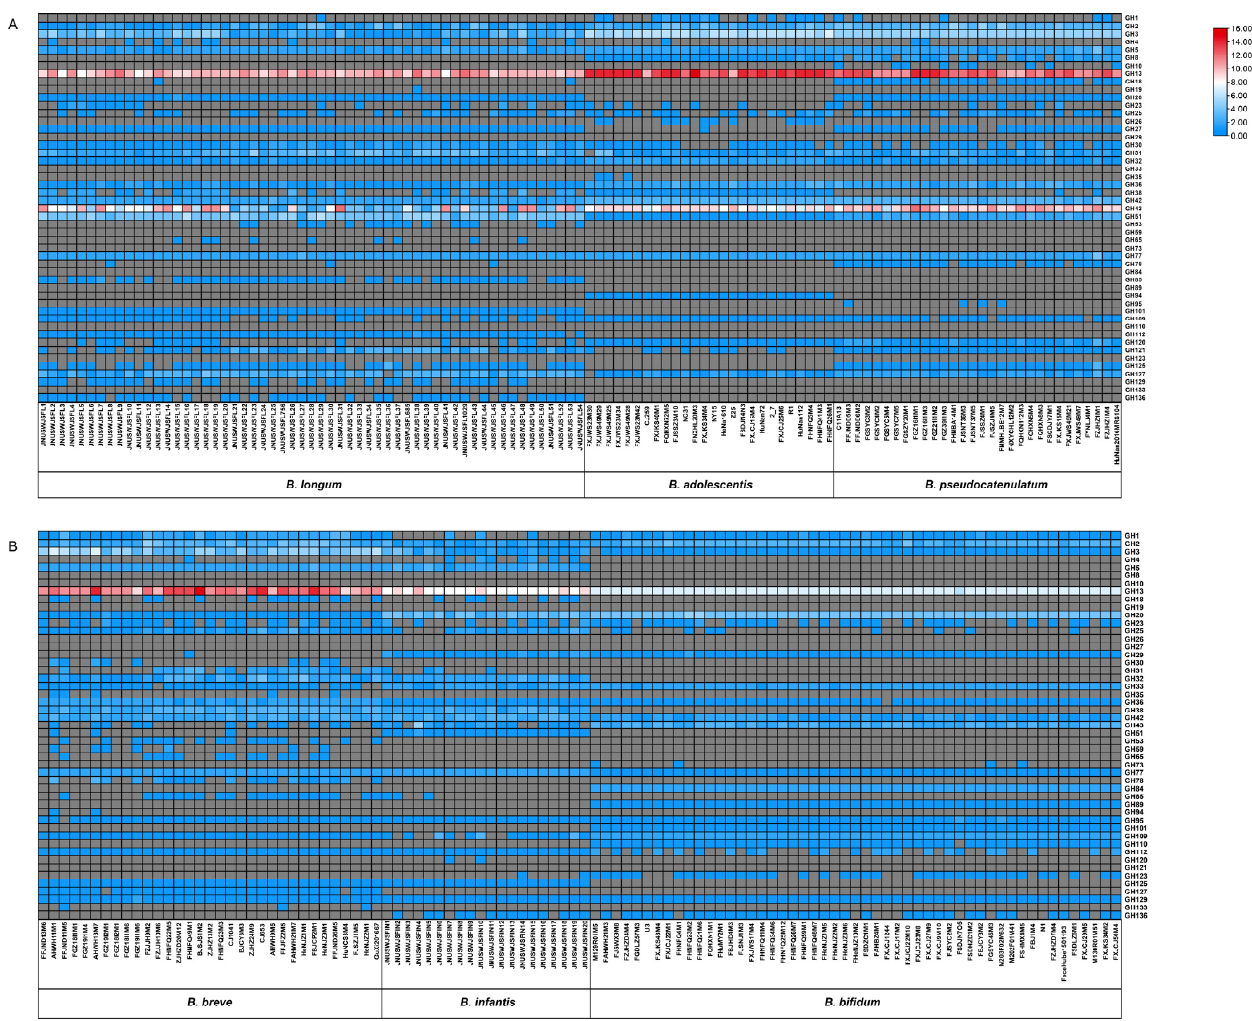
Figure 2 . Heatmap displaying the distribution and abundance of glycoside hydrolase (GH) family genes across Bifidobac- terium . Gene copy number of each of 48 GH families ranging from gray (absent) to red. ( A ), Heatmap illustrating the distribution and abundance of GH family genes across adult-type bifidobacteria. ( B ), Heatmap illustrating the distribution and abundance of GH family genes across infant-type bifidobacteria.